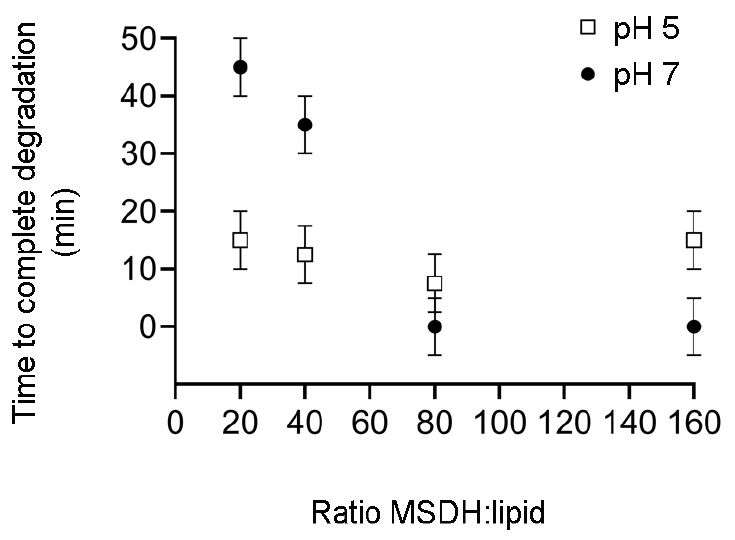
Figure 3. Time-dependence of complete degradation of liposomes. TRITC-dextran (40 kDa) was encapsulated in liposomes and mixed with increasing concentrations of MSDH. Leakage was analyzed at pH 7 and at pH 5 using fluorescence correlation spectroscopy. Degradation was considered complete when no spikes above 1500 kHz were visible during the entire measurement. For each data point, a series of FCS measurements was recorded for 40 min. The data is presented as the mean ± SD, estimated from multiple independent ( n > 3) measurements. p < 0.05 for MSDH/lipid ratio 40 vs. 80 and 20 vs. 80 at pH 7.